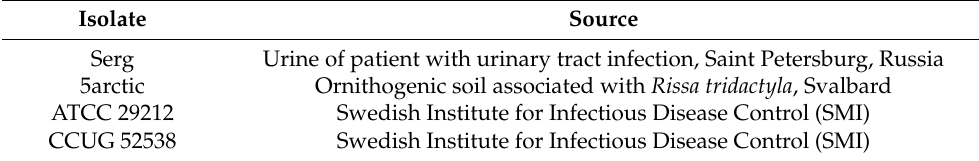
Table 1. Enterococcus faecalis strains used for